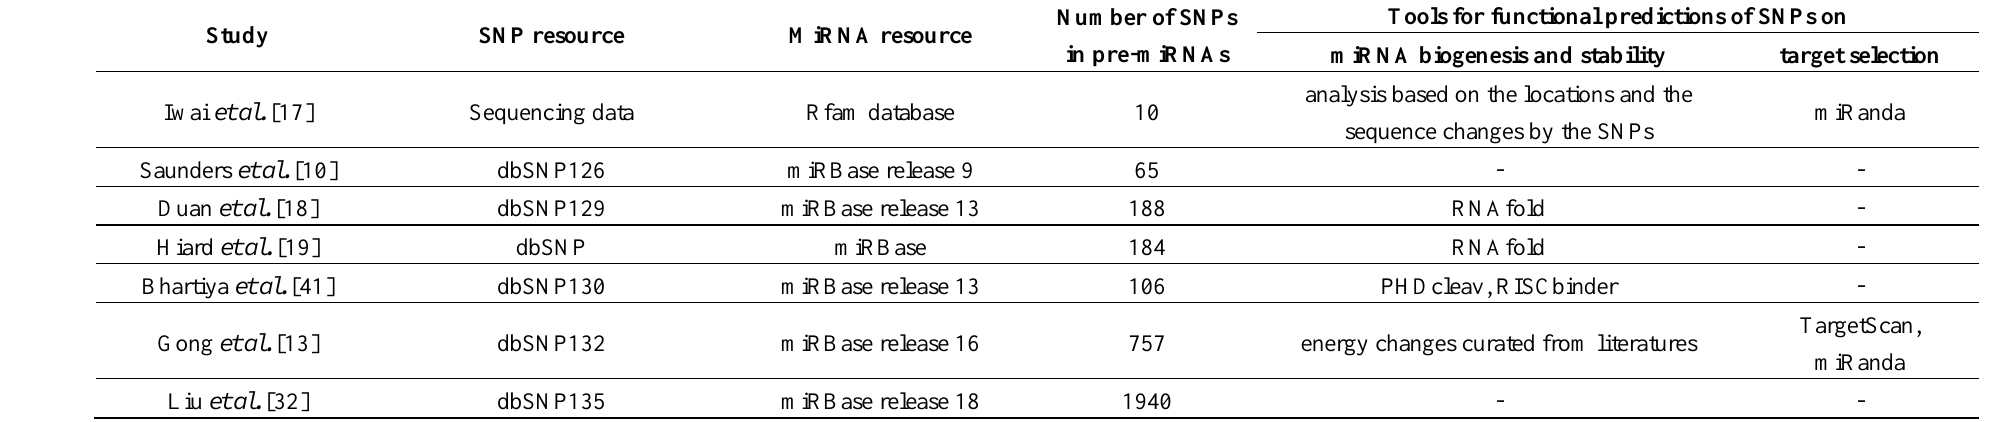
Table 1. Summary of Studies on single nucleotide polymorphisms (SNPs) within microRNA